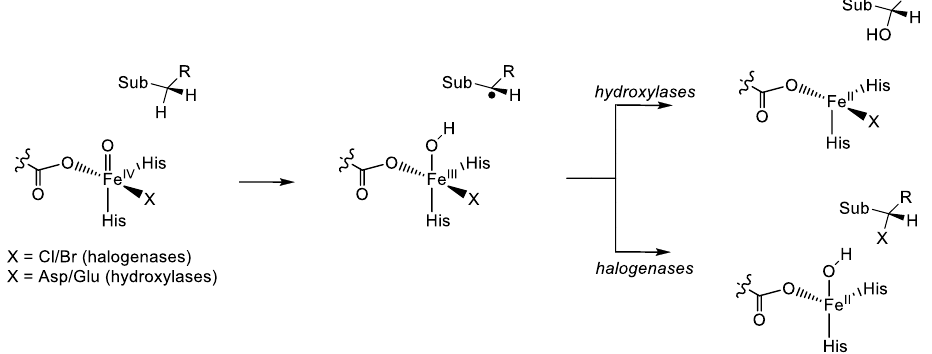
Figure 9. Catalytic mechanism of substrate halogenation versus hydroxylation of substrate by NHFeHa and NHFeHy enzymes.